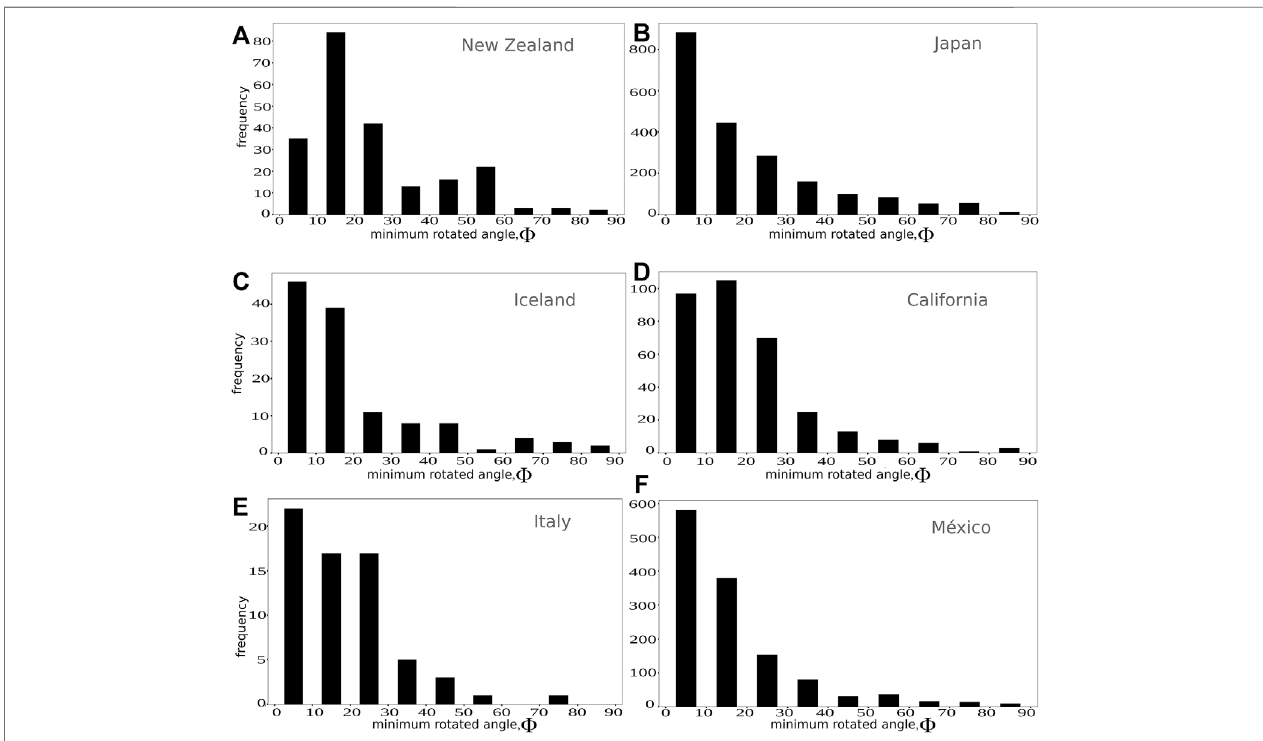
FIGURE5| Histogramdistributionof Φ valuesobtainedbythecomparisonbetweeneachneweventanditsnearestneighbors( k1 , k2 , k3 , k4 , kmedian ).Thevalues represented in the plot are the minimum Φ obtained in the nearest neighbor comparison.